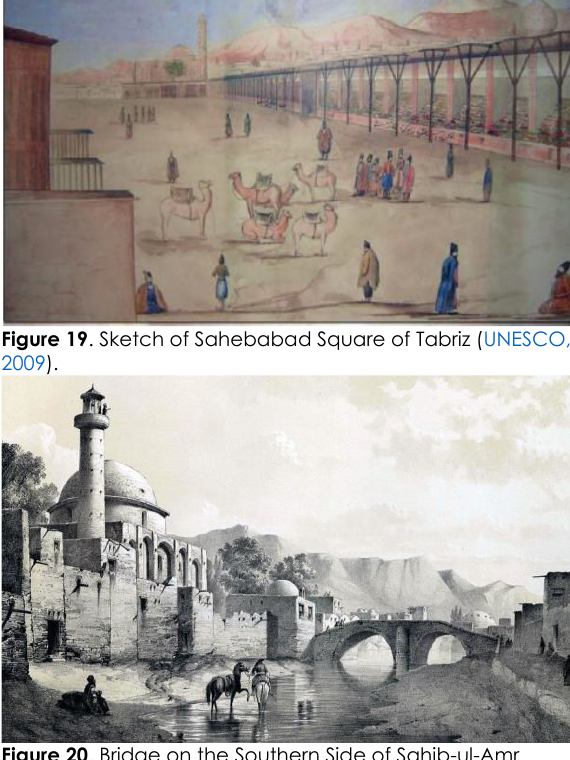
Figure 20 . Bridge on the Southern Side of Sahib-ul-Amr Shrine (Eugène Flandin) (UNESCO, 2009).